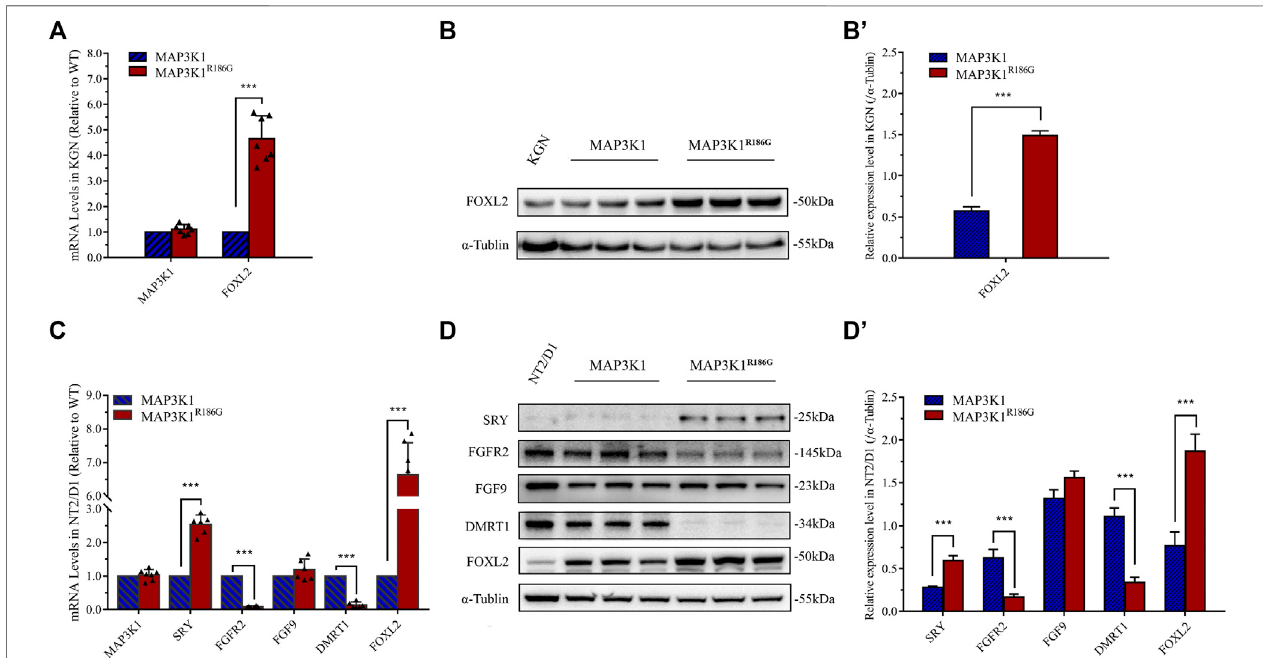
FIGURE 7 | Upregulated expression of pro-ovarian transcription factor FOXL2 gene. (A,B) KGN cells were transfected with empty vector plasmids expressing either wild-type (MAP3K1) or mutant (MAP3K1 R186G ) MAP3K1 genes. (A) mRNA levels of MAP3K1 and FOXL2 were measured using quantitative PCR. (B) Western blotting analysis of MAP3K1 and FOXL2. (B 9 ) Quanti fi ed analysis of western blotting of FOXL2. (C,D) NT2/D1cells were transfected with empty vector plasmids expressingeitherwild-type(MAP3K1)orvariant(MAP3K1 R186G )oftheMAP3K1gene. (C) mRNAlevelsofMAP3K1,SRY,FGFR2,FGF9,DMRT1,andFOXL2were measured using quantitative PCR. (D) Western blotting analysis of SRY, FGFR-2, FGF-9, DMRT1, and FOXL2. (D 9 ) Quanti fi ed analysis of Western blotting of MAP3K1, SRY, FGFR-2, FGF-9, DMRT1, and FOXL2. For quantitative PCR, results were normalized to β -actin as a reference and compared with control cells transfected with an emptyvectorplasmid( n ≥ 5;mean±SEMshown;*** p < 0.001byStudentt-test).ForWesternblotting,resultswerenormalizedto α -tubulinasareferenceandcompared with control cells transfected with empty plasmids ( n = 3; mean ± SEM shown; * p < 0.05, ** p < 0.01 and *** p <